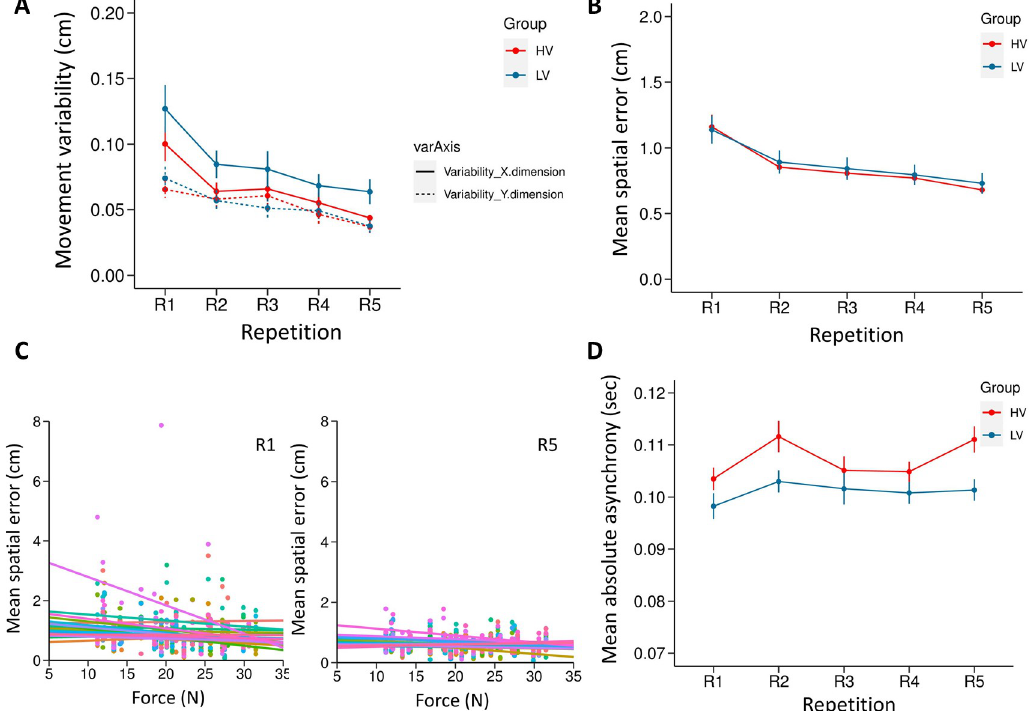
Fig 7. Results of Experiment 2. (A) Normalized variability of participant’s movement in the horizontal and vertical dimension. (B) Spatial error as a measure of individual performance. The spatial error at each repetition is an average of all 8 configurations from each of the 8 blocks. (C) Repeated measures correlation analysis between the force perturbation experienced and the spatial error of the participants in the HV group, for R1 and R5 separately. Each participant’s data and corresponding rmcorr fit lines are shown in different colors. (D) Absolute Asynchronies as a measure of joint performance. All error bars display standard error of